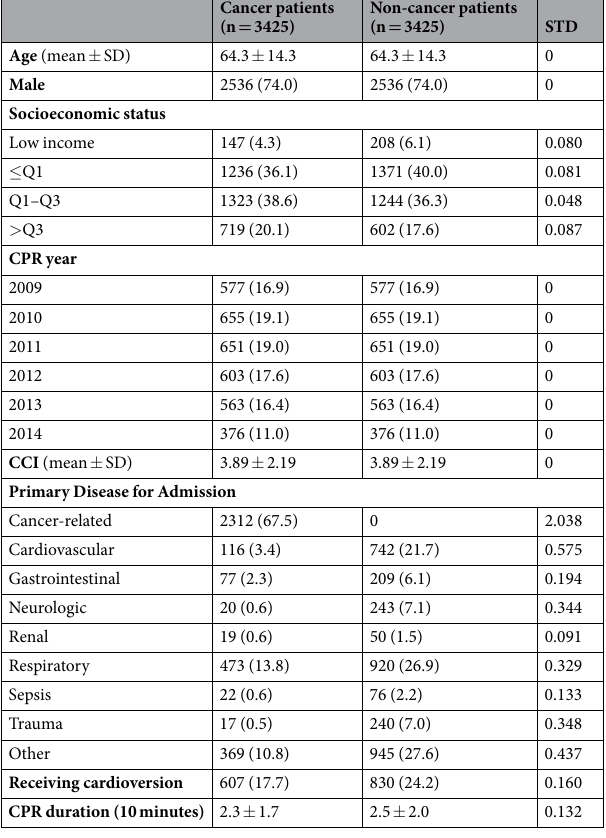
Table 3. Clinical characteristics of matched stage IV cancer and non-cancer patients who received in-hospital CPR (21 stage-IV cancer patients could not be matched with noncancer patients and were therefore excluded from this analysis). Note: CCI, charlson comorbidity index; CPR, cardiopulmonary resuscitation; SD, standard deviation; STD, standardized difference; TKI, tyrosine kinase inhibitor. Data are number (%) unless otherwise